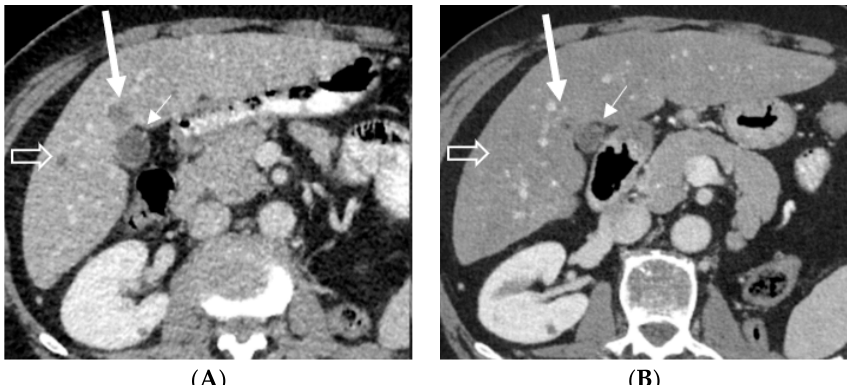
Figure 3. Axial contrast-enhanced abdominal CT: baseline, prior to EV treatment ( A ), and after three cycles of EV ( B ) shows almost a complete disappearance of the hypodense liver metastasis (long arrow) in front of the gallbladder (short arrow) and disappearance of a smaller metastasis (open arrow) in the right lobe after treatment. Abbreviations: CT, computed tomography.